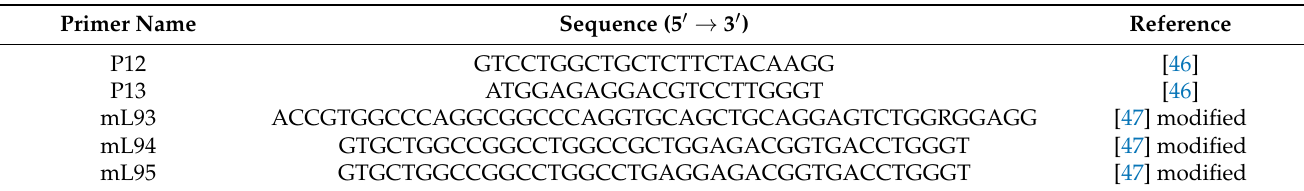
Table 1. Primer sequences for the amplification of VHH DNA